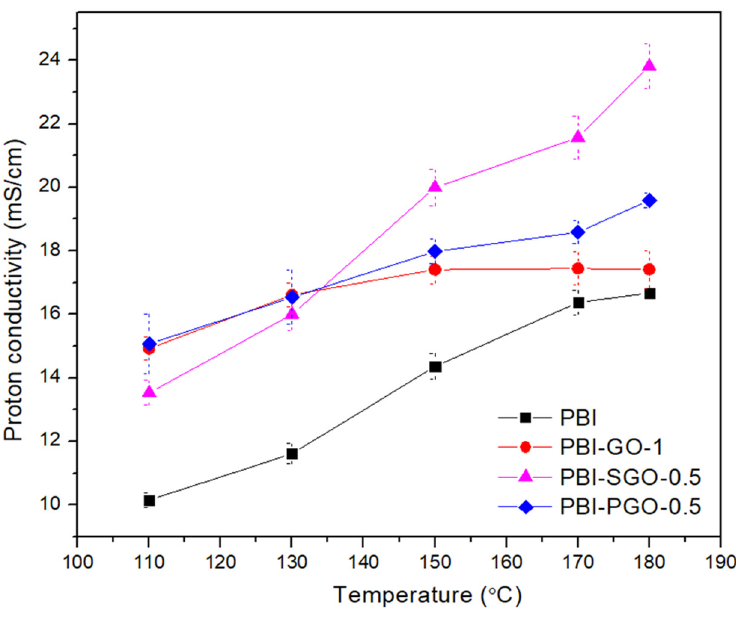
Figure 9. Proton conductivity of the selected composites compared with pure PBI.